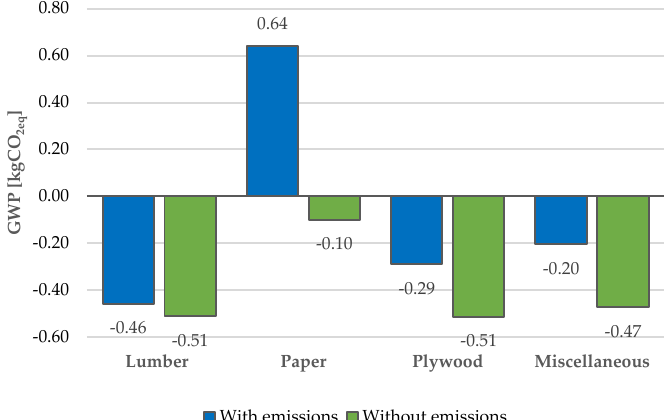
Figure 4. Global warming mitigating role of wood products from private forests in Washington state, calculated over a 100-year timeframe. Results include the scenario where fossil fuel-based life cycle emissions from wood products manufacturing are included (blue) and excluded (green).